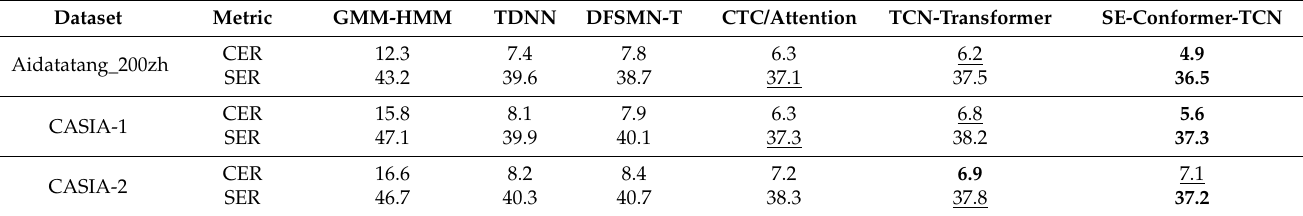
Table 3. SE-Conformer-TCN comparison with recent work.